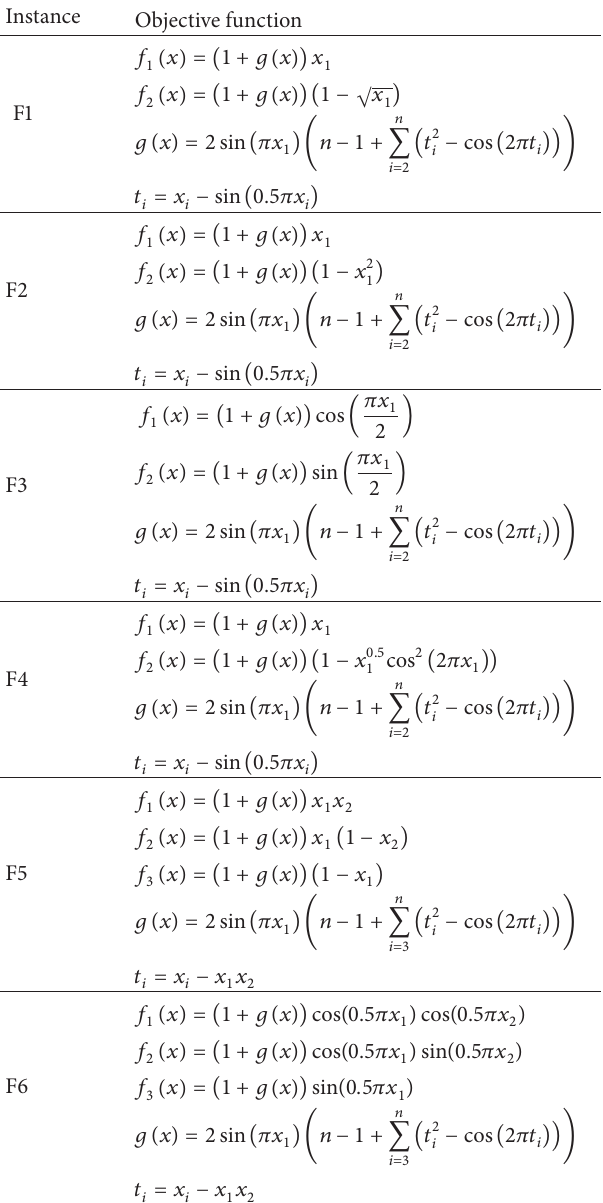
Table 1: Multiobjective benchmark functions.